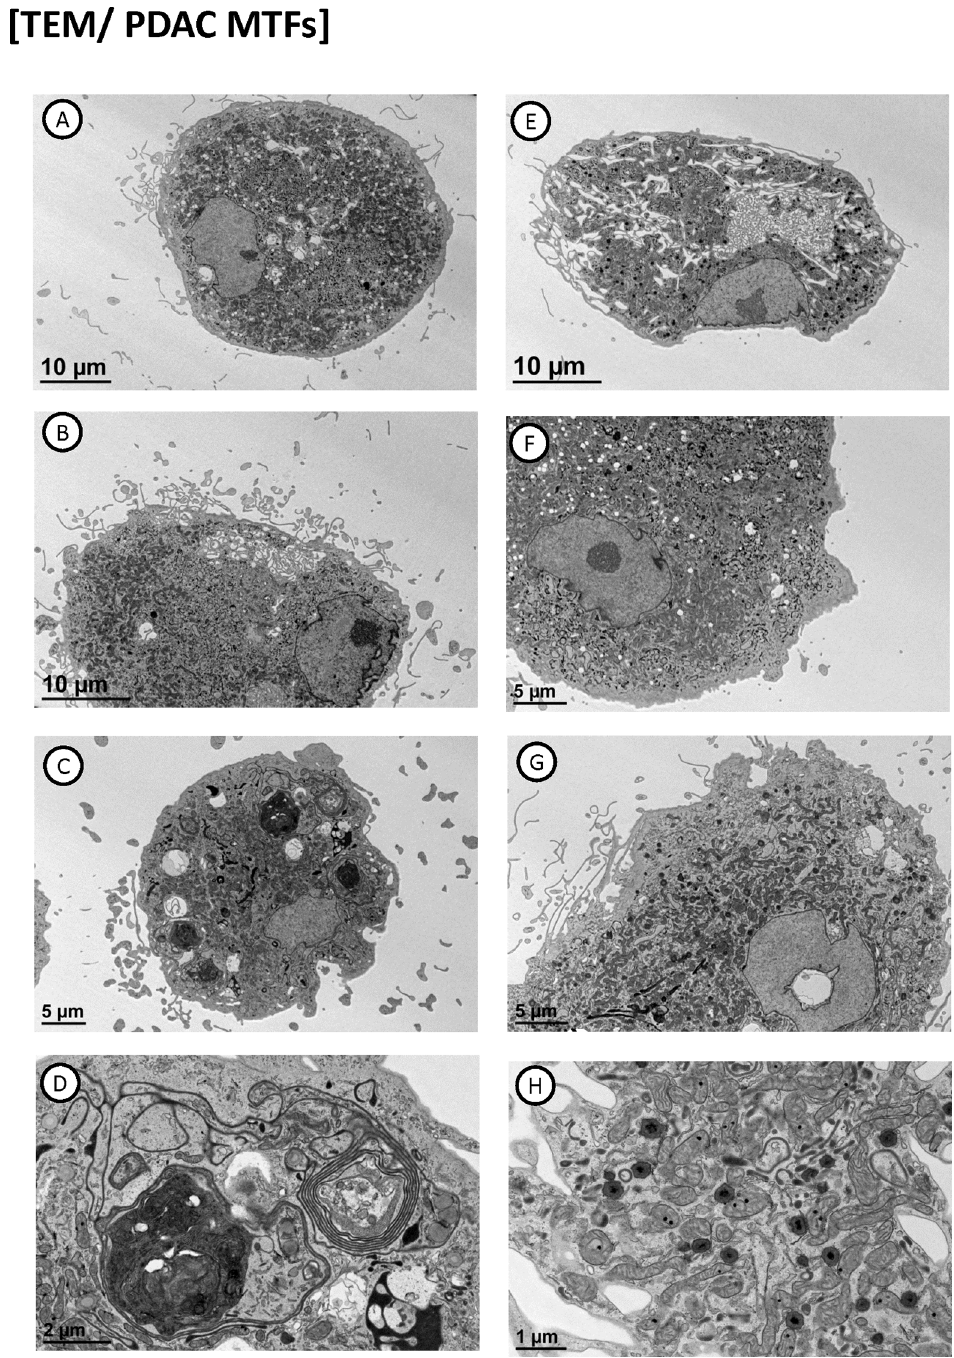
Fig 6. Transmission electron microscopy of cultured MTFs. Panels A-H show representative cells with distinctive features, including cytoplasmic“tunnels” through nuclei (Panel G ). Focal hyper-denseregions of chromatin(Panel A , E , and F ), autophagicbodies (Panel D ), etc. are evident within the individual